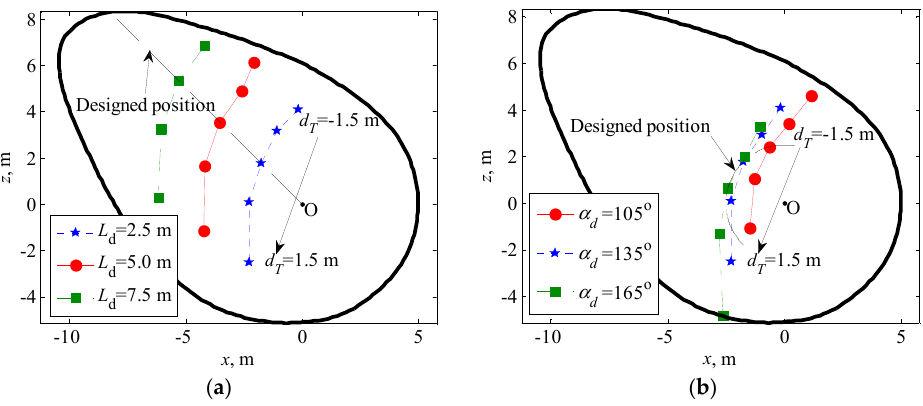
Figure 14. Position of the movable mass variation with tidal height at different wave frequencies and mass ratios: ( a ) for different radial distance of the designed position at α d = 135°, b = 0.2, and f = 0.1 Hz; and ( b ) for different angle of the designed position at L d = 2.5 m, b = 0.2, and f = 0.1 Hz.